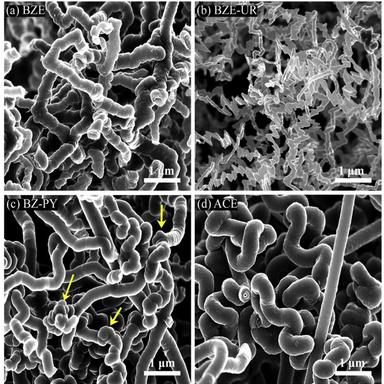
SEM images of carbon fibers. (a) Sample BZE, (b) sample BZE-UR, (c) sample BZ-PY, and (d) sample ACE. The diameter size and morphology of the carbon fibers depend strongly on the precursor used for their synthesis. The largest diameters correspond to that synthesized with acetonitrile-ethanol. Carbon fibers from samples BZE and BZE-UR exhibited a zigzagging behavior, whereas samples BZ-PY and ACE showed entangled wavy carbon fibers. The diameter distribution plots are shown in SEM, scanning elec